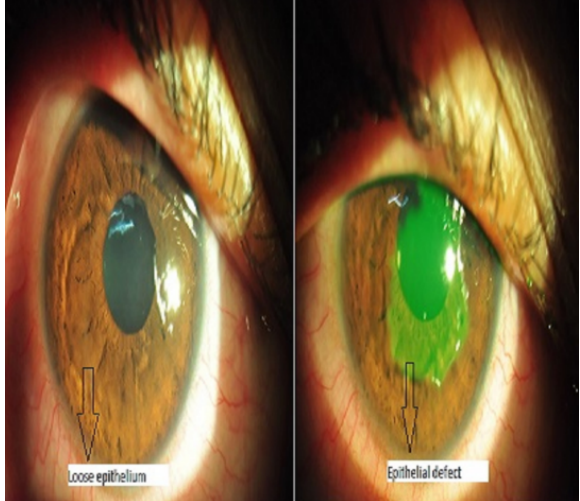
Figure 1: Slit lamp photo of the right eye showing large corneal epithelial defect with surrounding loose epithelium